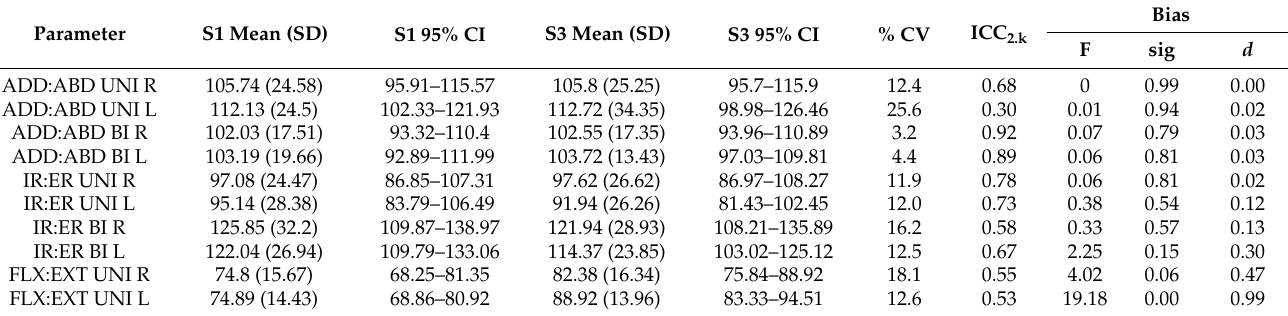
Table 5. Inter-session reliability-peak torque hip agonist:antagonist ratio